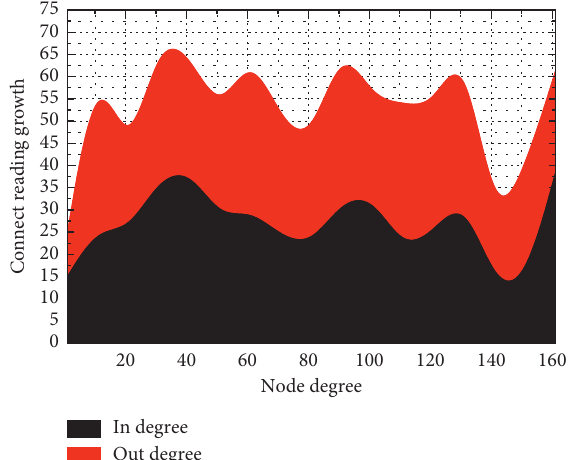
Figure 8: The relationship between the initial connection probability and the average increase of the agent out-degree and in-degree.